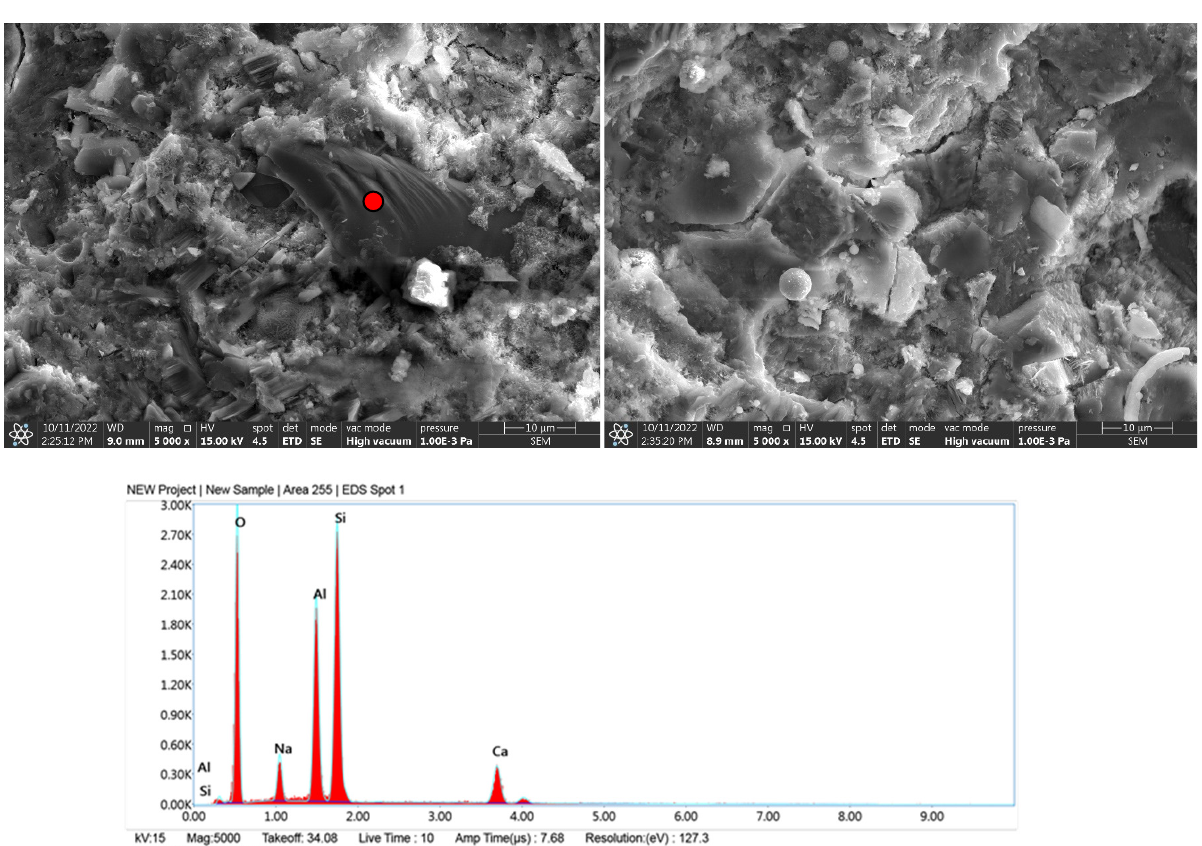
Figure 8. Microphotographs with EDS analysis of sample with unground granite powder.